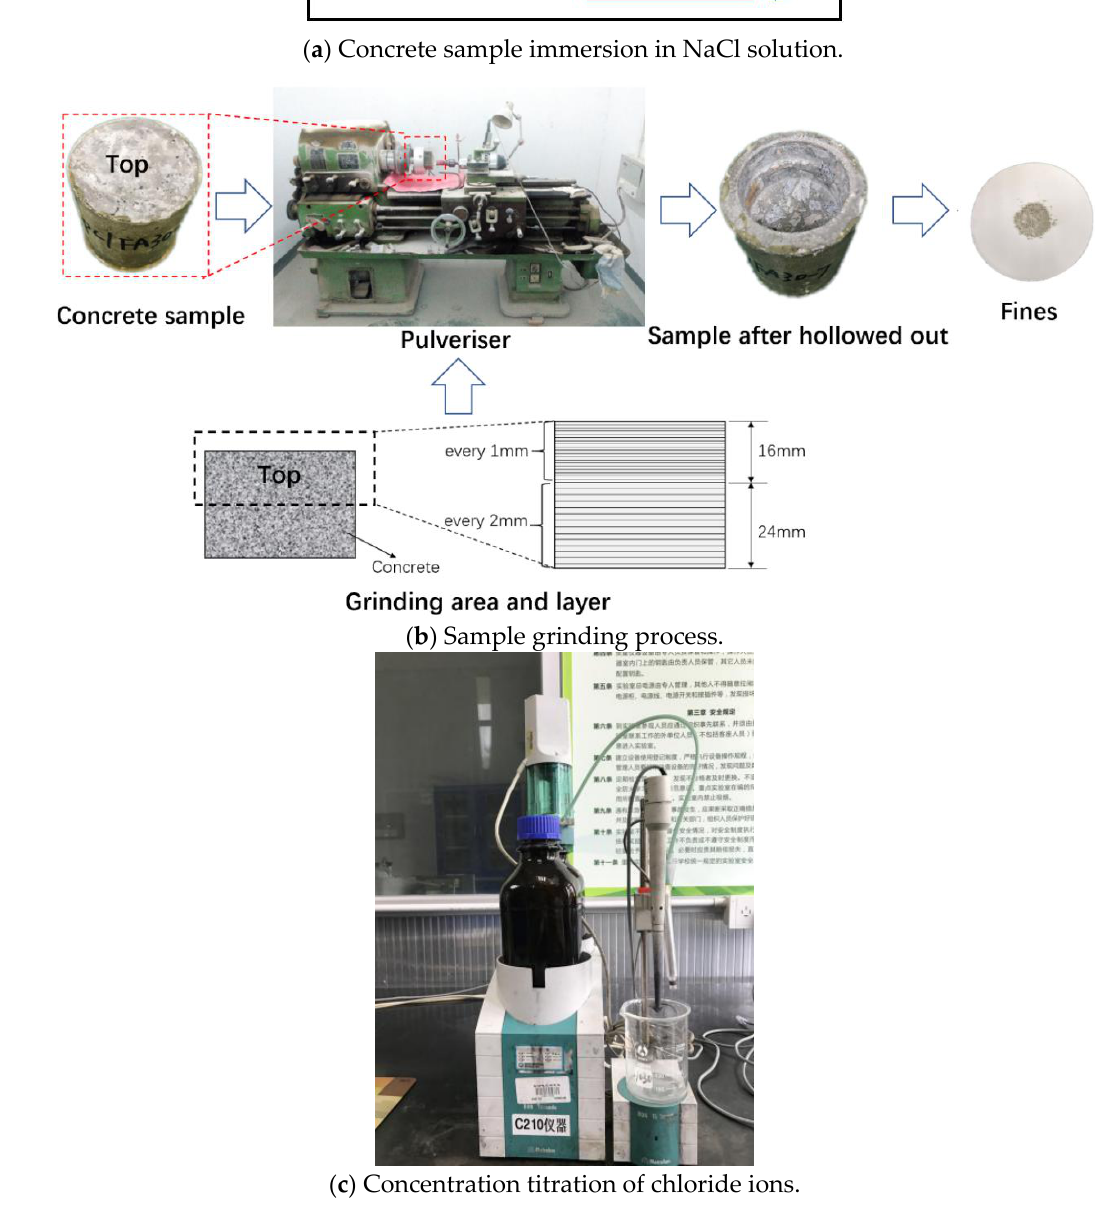
Figure 1. Measurement of chloride content in concrete.